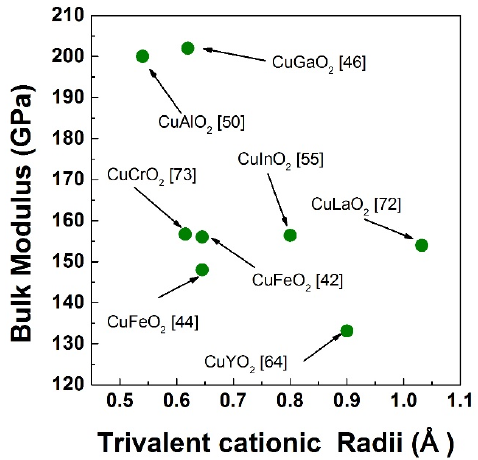
Figure 13. Landscape of bulk modulus of various copper delafossites as a function of trivalent cationic radii. Numbers in the bracket indicate the references.